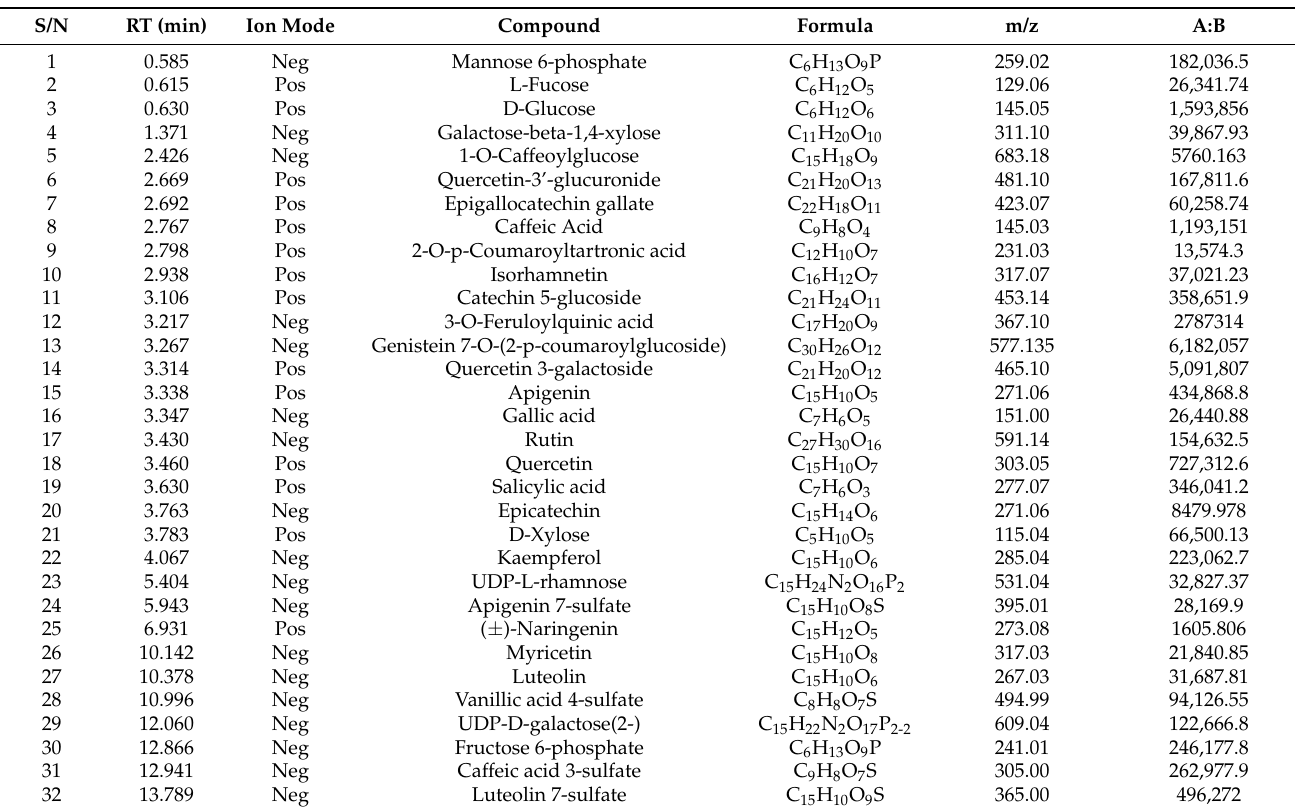
Table 2. UHPLC-MS analysis of A. hendersonii methanol leaf